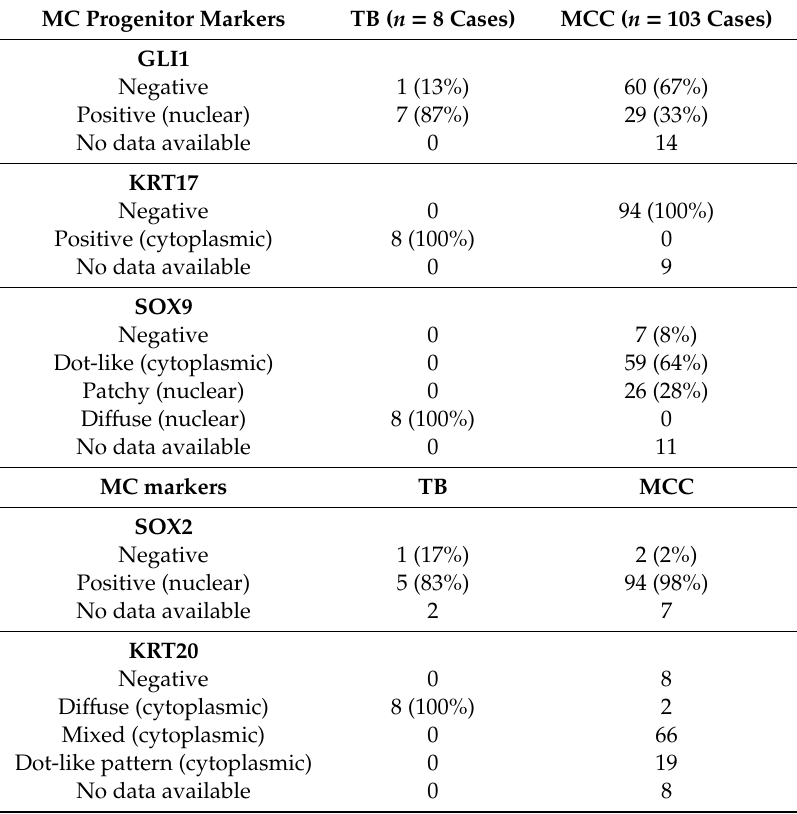
Table 1. Expression of Merkel cell progenitor markers in trichoblastoma ( n = 8) and Merkel cell carcinoma ( n =